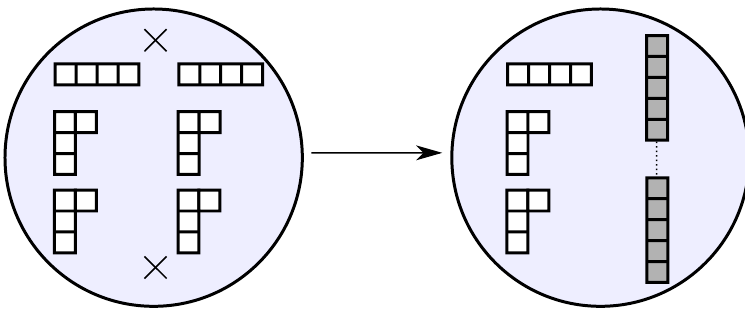
Figure 4 . Illustration of the quotient action. Before the quotient, we have a six-punctured sphere with four minimal untwisted punctures (shown as the Young diagram [3 , 1] ) and two maximal untwisted punctures (shown as the Young diagram [1 4 ] ). Additionally we show the two fixed points of the quotient action as black crosses. After the quotient, we obtain a five-punctured sphere, where the two minimal twisted punctures are shown as the gray Young diagram [5] . There is a Z line (shown as a black dotted line) connecting these two twisted